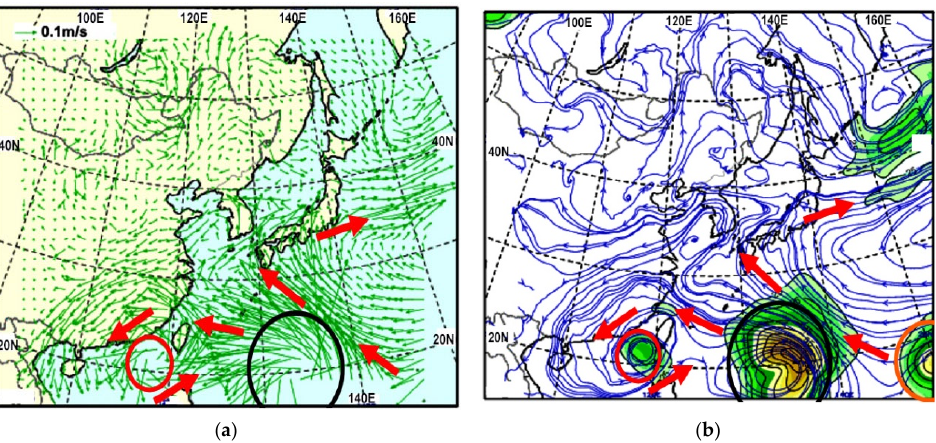
Figure 15. As shown in Figure 4, except for ( a ) moisture flux (0.1 kg ∙ m/s) and ( b ) streamline with isotaches at 09:00 LST, 8 July. In ( b ), as STS Linfa (left) was strongly pulled by the more intensified TY Chan ‐ Hom (center) by mutual interaction of the MLCT and TY Nangka (right), it kept the same central pressure and maximum wind speed.